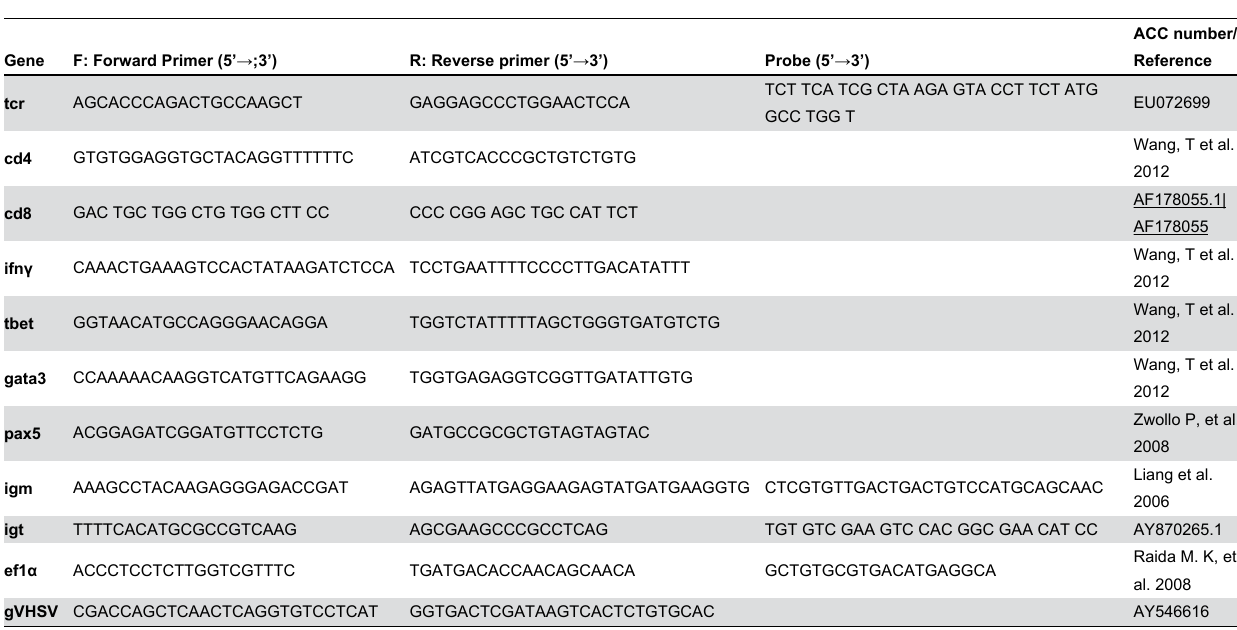
Table 1. Primer and Probe